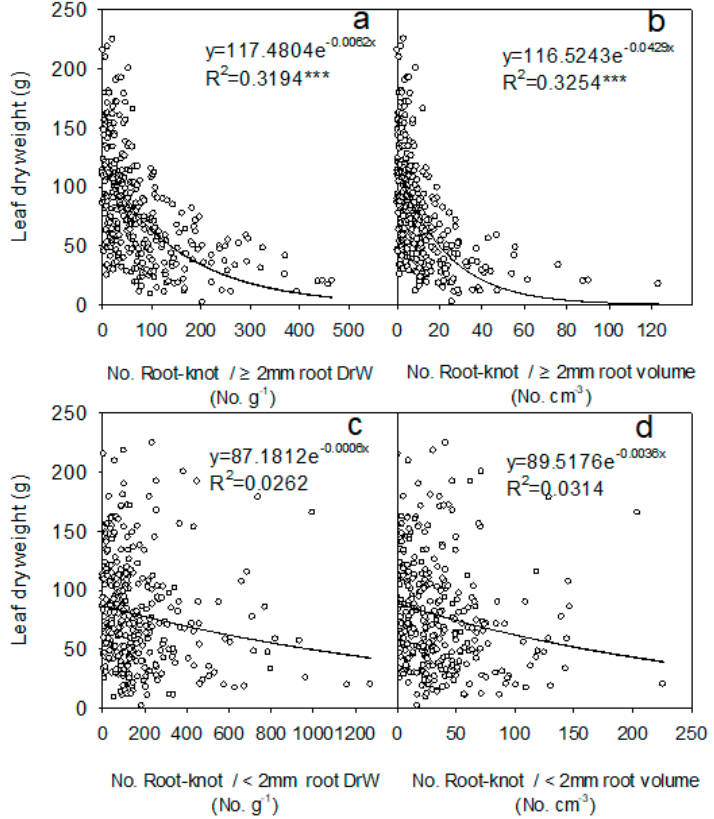
Figure 4. Regressionbetween the leaf dry weight and root-knot density described as root-knot number per gram (No. g − 1 ) or volume (No. cm − 3 ) of the roots with a diameter ≥ 2 mm or <2 mm. Significant level: ***, p <